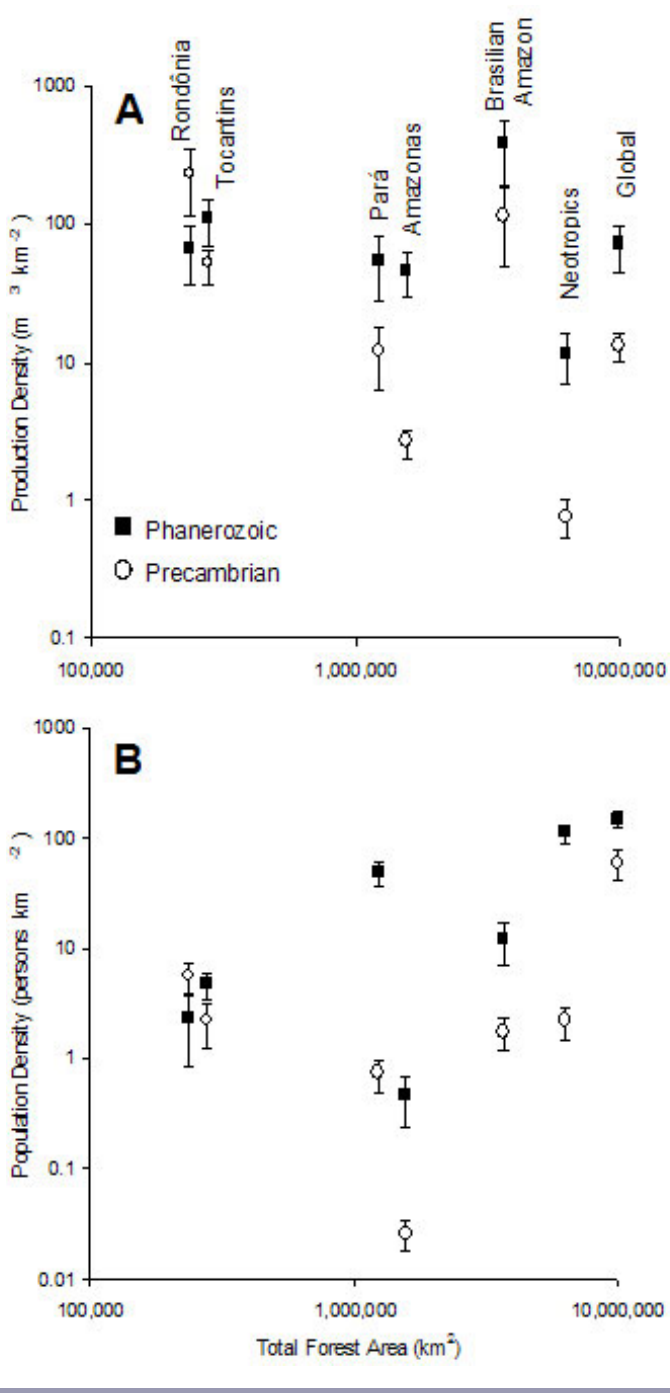
Fig. 4. Relationship between geology and (A) Tropical roundwood production density and (B) Population density as seen when drilling down along a Neotropical pathway. Note log